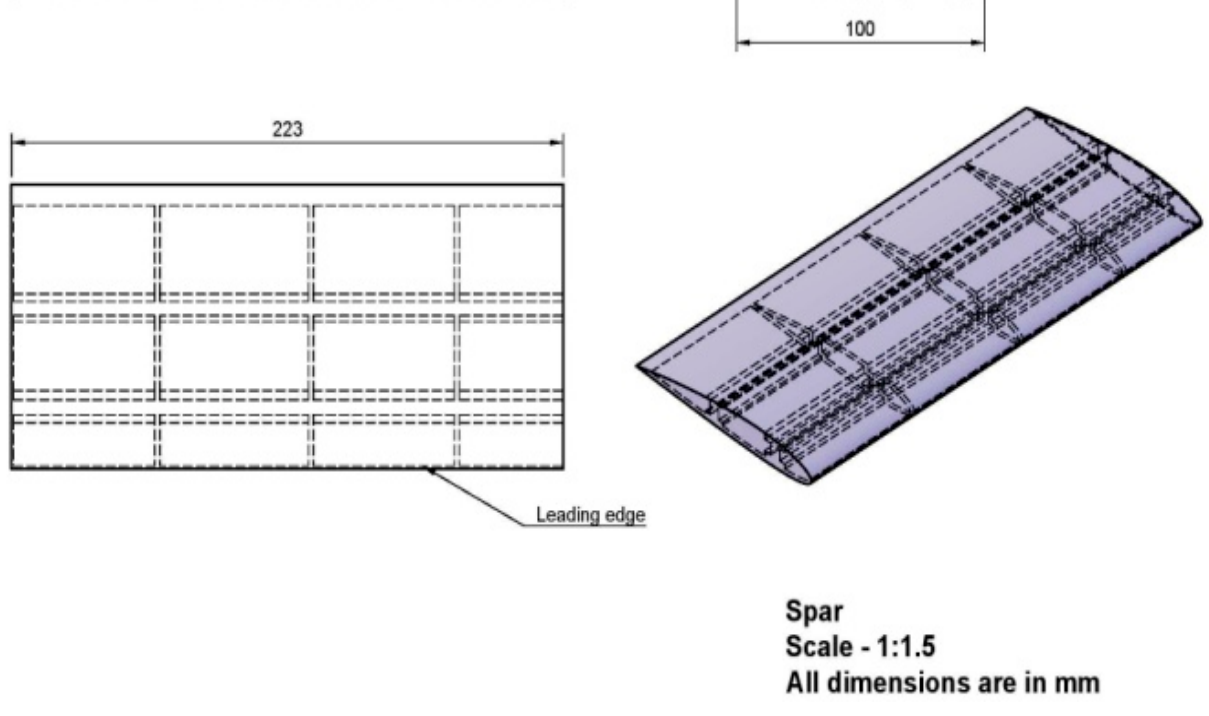
Figure 5. Design draft of UAV’s wing.